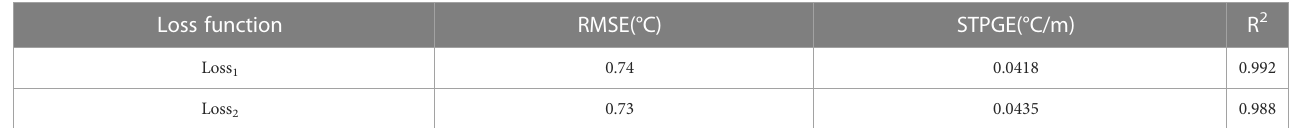
TABLE 1 Comparison of metrics on test set using different loss